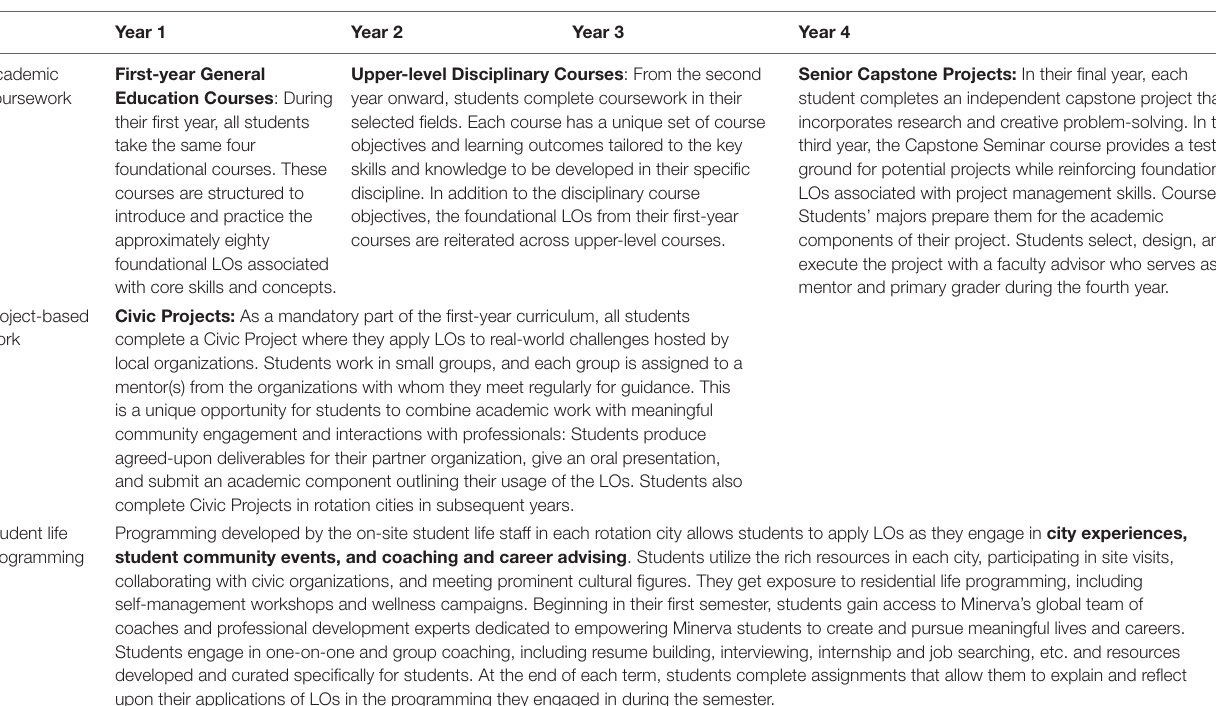
TABLE 2 | Key elements of the Minerva University learning